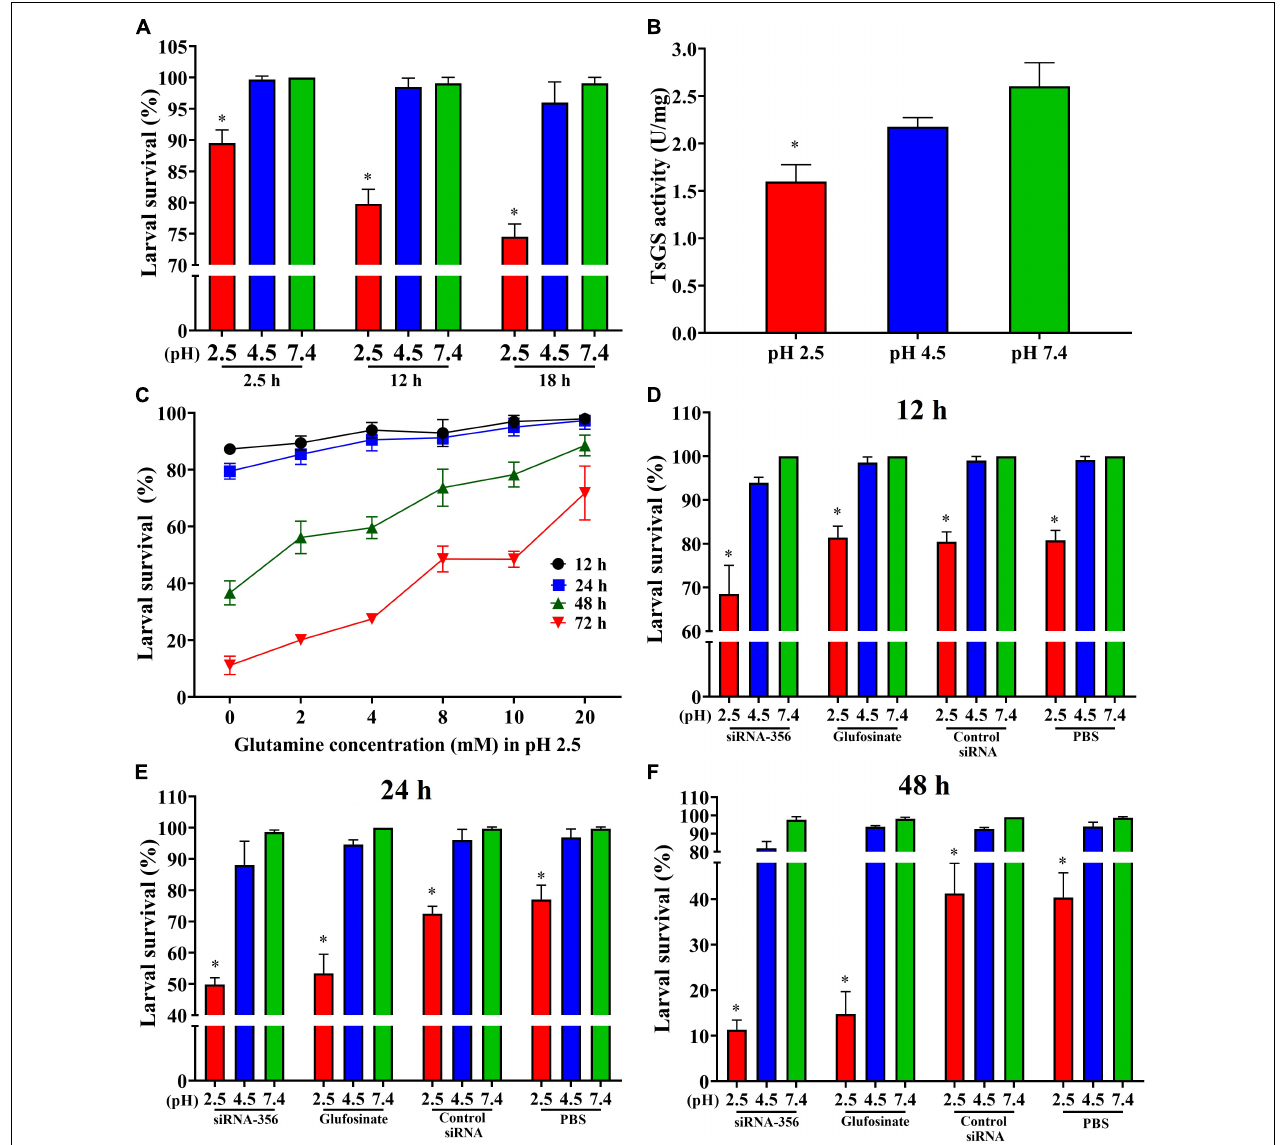
FIGURE 10 | Acid-resistant tests of Trichinella spiralis muscle larvae. The effect of various acidic conditions on the survival of T. spirali s muscle larvae (ML) was assessed. One hundred ML were cultured at pH 2.5, 4.5, and 7.4 at 37 ◦ C and 5% CO 2 for 2.5, 12, and 18 h. The survival of the ML cultured in phosphate-buffered saline with various pH values was examined under a microscope on the basis of larval viability. Inactive, straight, or “C”-shaped larvae were assessed as dead larvae. The mobile and wriggly larvae were counted as live larvae. (A) Effect of different pH on ML survival in various culture times. (B) TsGS enzyme activity of the ML cultured at pH 2.5 for 18 h. (C) Effect of different glutamine concentrations on the survival of ML at pH 2.5. (D–F) Silencing of TsGS gene was reduced on larval survival at pH 2.5 for 12 (D) , 24 (E) , and 48 h (F) . * P < 0.05 compared to the pH 7.4